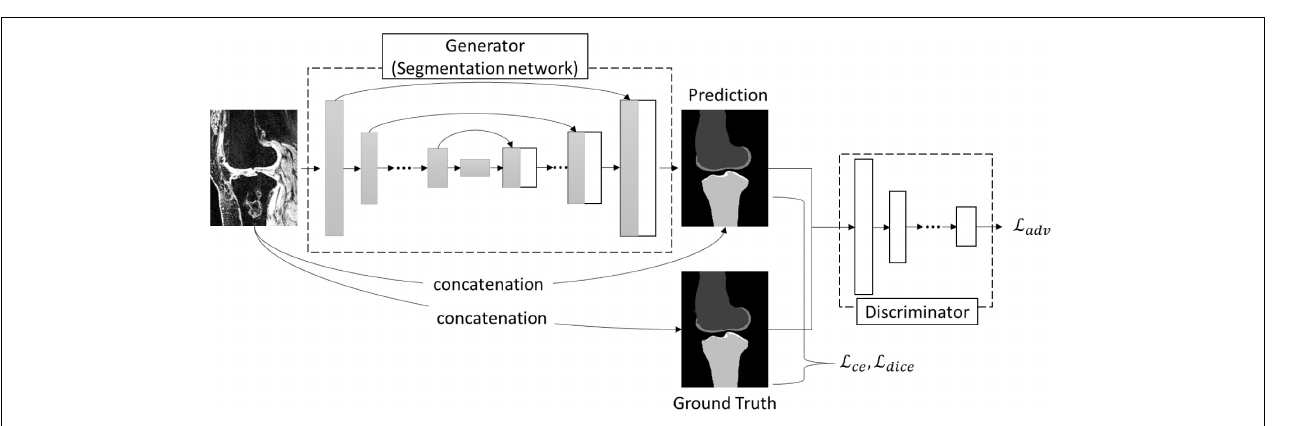
FIGURE 2 | The architecture of the bone